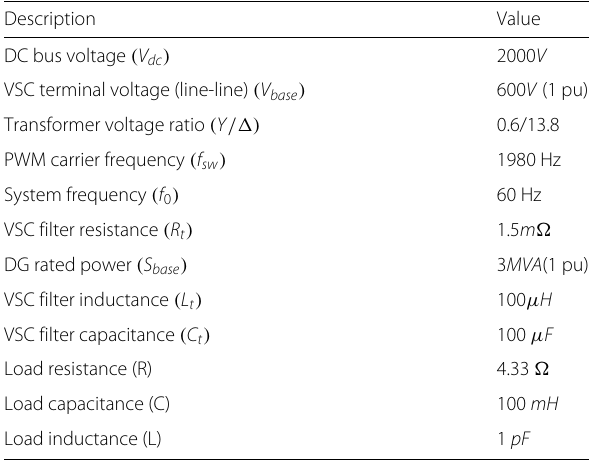
Table 2 Parameter values for three phase microgrid